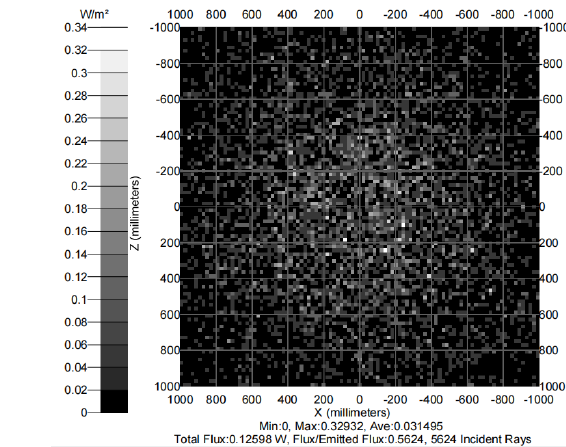
Figure 9. LED light distribution curve without secondary light source design.